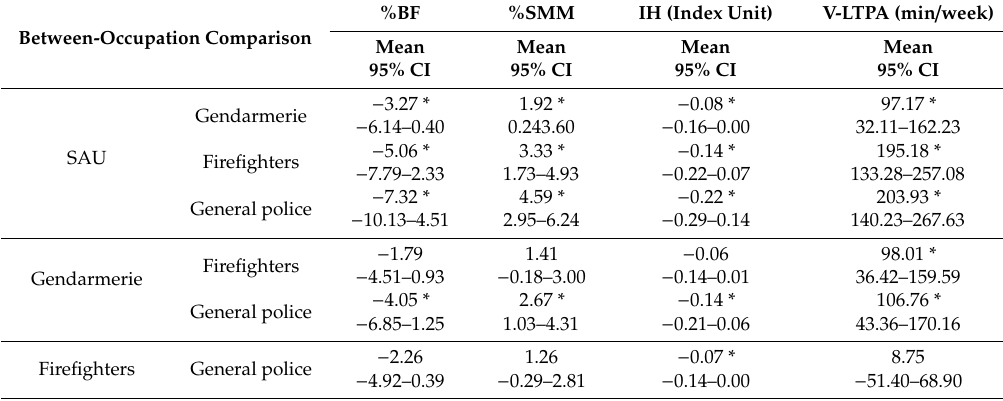
Table 3. Di ff erences between police occupations in body composition and leisure-time physical activity obtained by Bonferroni post hoc